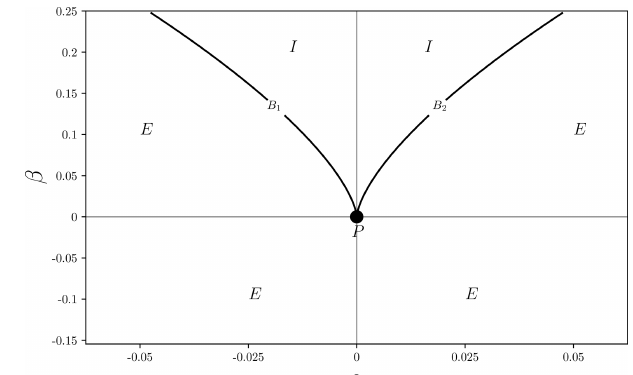
Figure 3. Discriminant determining the stability and number of critical points. The splitting factor β and normal factor α describe the stability diagram. The bimodal regime ( I ) is separated from the unimodal regime ( E ) by two lines ( B 1 , 2 ) that meet at point P